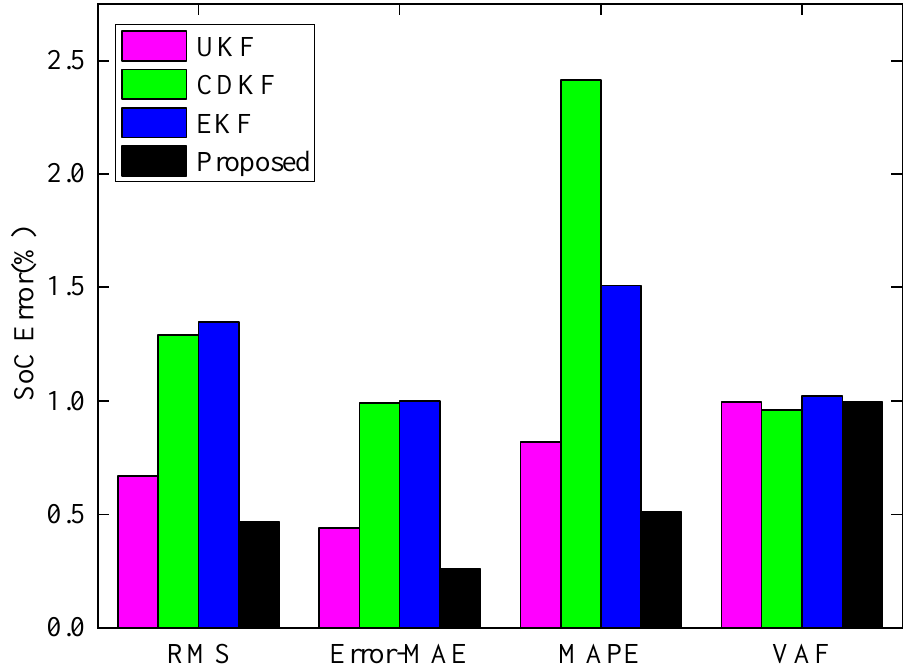
Figure 16. The four evaluation indexes of the initial SoC guess were 0.9 under the US06 condition. Table 6. Comparison of SoC estimation errors of four algorithms.